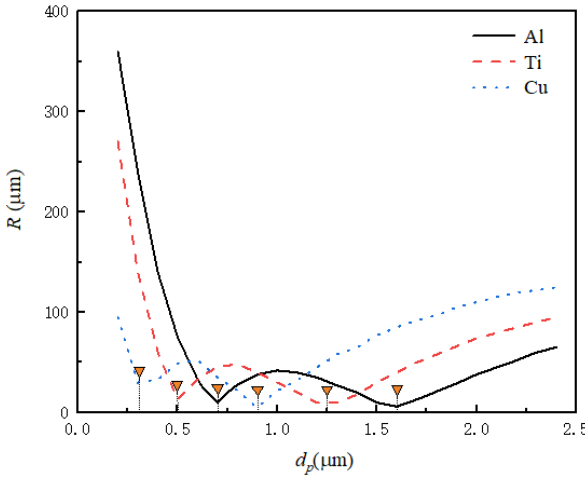
Figure 13. Diffusion radius of particles at the nozzle outlet.